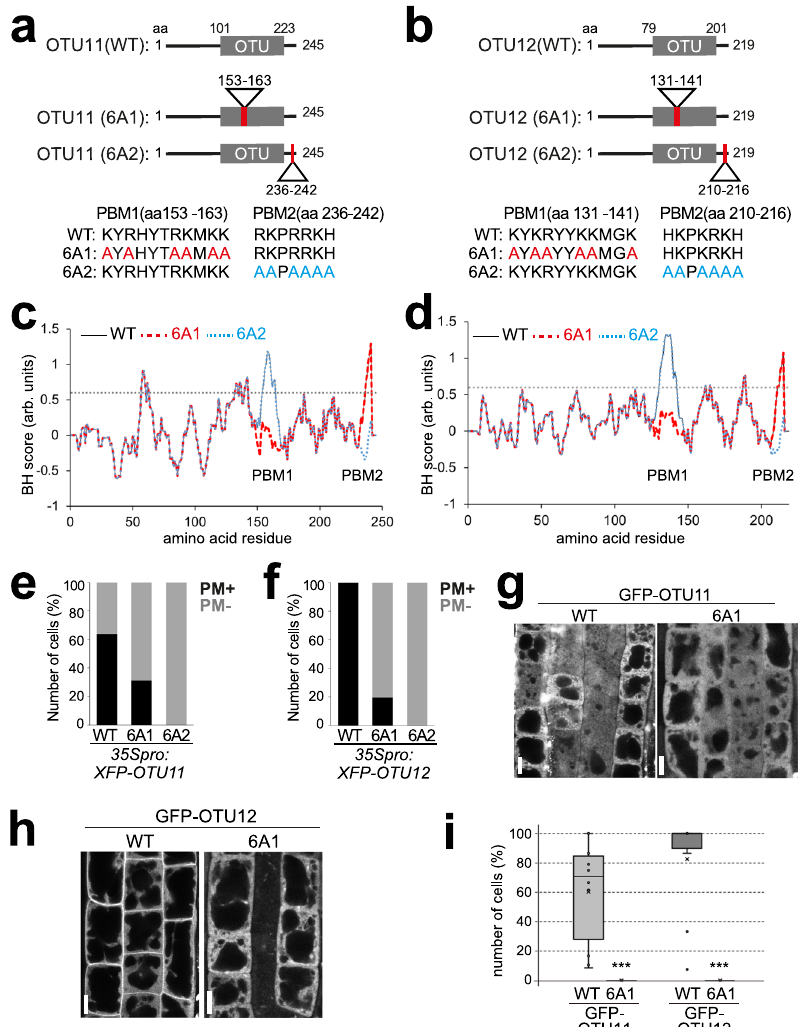
Fig. 2 | Polybasic motifs in OTU11 and OTU12 are required for the PM locali- zation. a , b OTU11(a) and OTU12(b) constructs used for this study. c , d BH-scores (window=10) of OTU11(WT) (thin black line), OTU11(6A1) (dotted red line) and OTU11(6A2) (dotted blue line) ( c ) and OTU12(WT) (thin black line), OTU12(6A1) (dotted red line),and OTU12(6A2)(dottedblue line) ( d ).The thresholds of 0.6 are indicated with dotted lines. Wild-type OTU11 and OTU12 have two large peaks correspondingtoPBM1andPBM2.The6A1mutationleadstothelossofthePBM1- peak, whereas the 6A2 mutation causes the loss of the PBM2 peak. e , f PBM1 and PBM2 of OTU11 and OTU12 are important for the PM localization in cellula . Ara- bidopsis root cell culture-derived protoplasts were transformed with 35Spro:RFP - OTU11(WT) ( n =22 cells), 35Spro:Y/RFP-OTU11(6A1) ( n =32 cells), or 35Spro:YFP- OTU11(6A2) ( n =20 cells) constructs ( e ) or with 35Spro:YFP - OTU12(WT) ( n =77 cells), 35Spro:YFP-OTU12 (6A1) ( n =56cells),or 35Spro:YFP-OTU12(6A2) ( n =15 cells) constructs ( f ). The distribution of fl uorescent signals in the cells was analyzed by confocal microscopy and categorized in +PM (signals atPM) and − PM (signalsnot at PM). At least two independent transformations were performed for each set